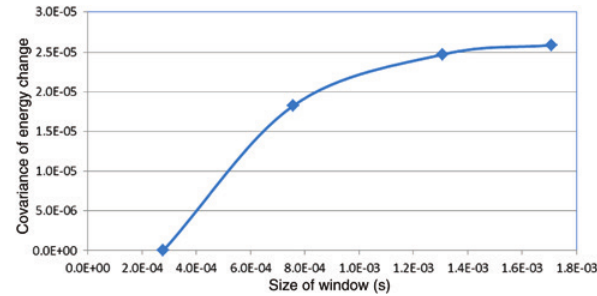
Figure 27: Covariance of energy change at Section 2 with varying damage depth.